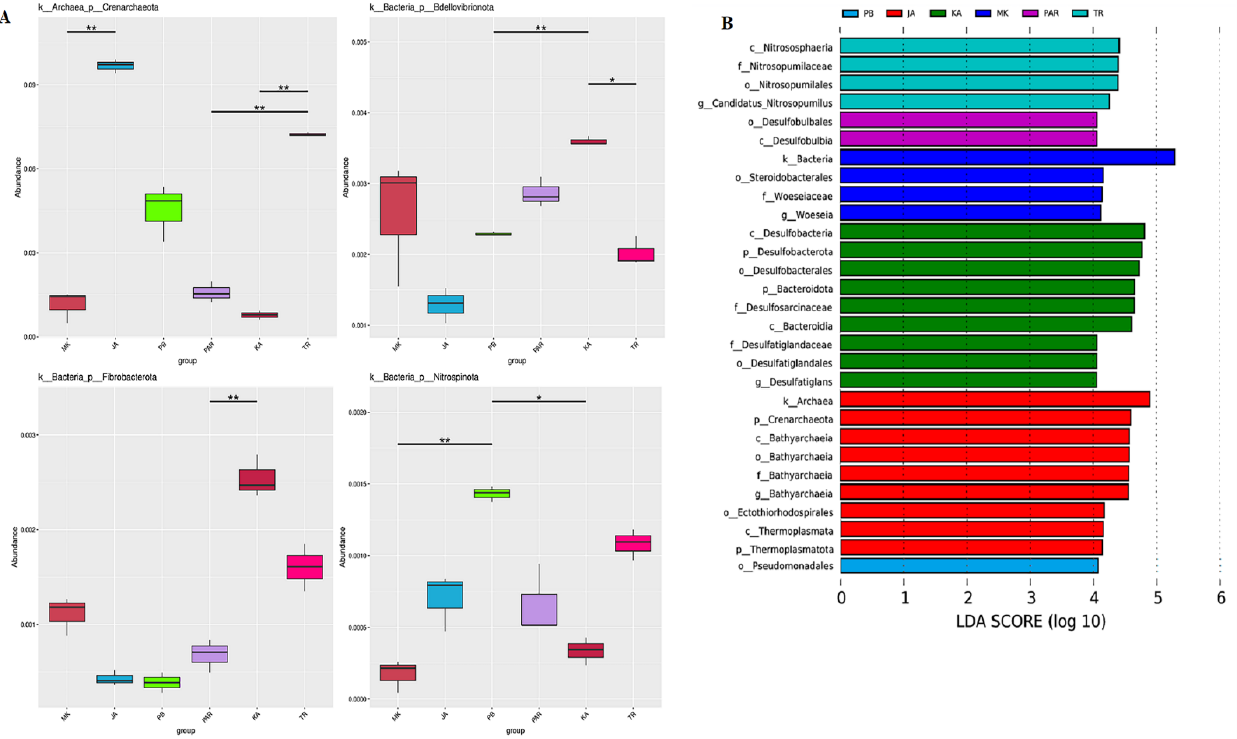
Figure 3. Between-group variation analyses. Bar chart showing the abundance of bacterial phyla in each sampling site ( A ). A double asterisk represents a highly significant variation ( p < 0.01), and a single asterisk represents a significant variation ( p < 0.05); histogram of LDA scores for evaluation of biomarkers whose numbers were statistically different among sampling sites ( B ). The site codes are in accordance with those listed in Table 1 .